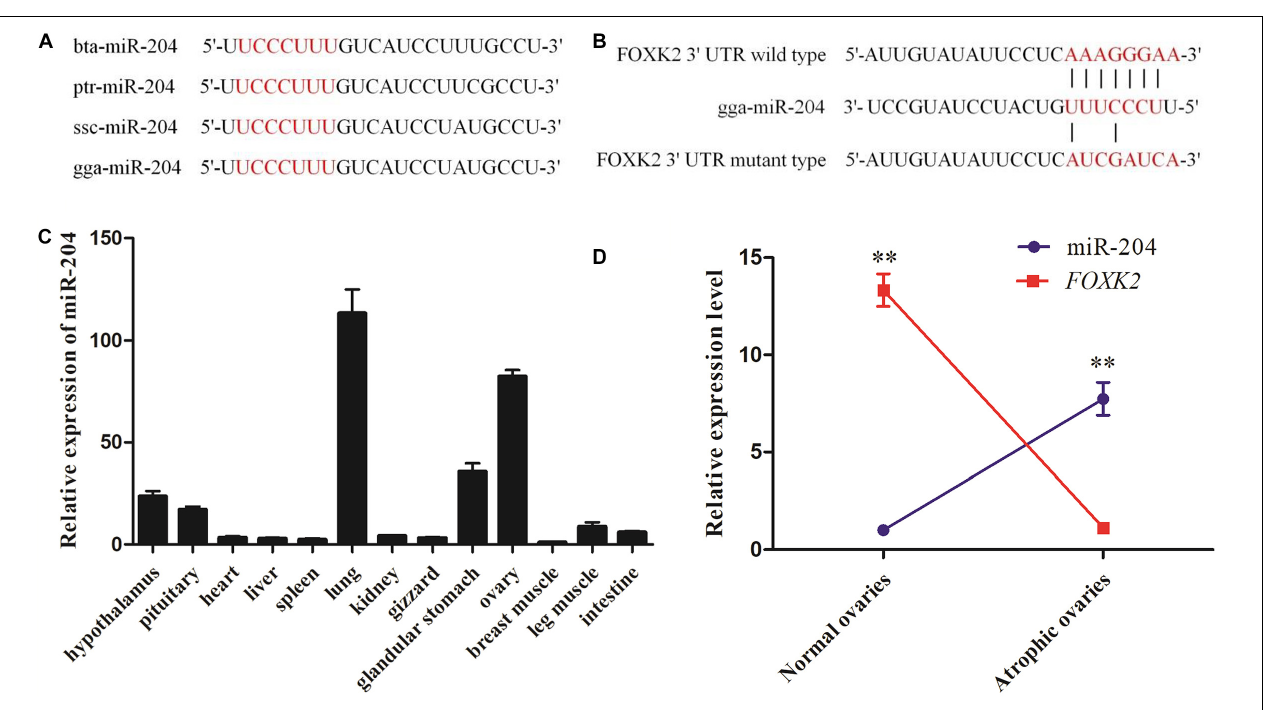
FIGURE 1 | Sequencing characteristics, expression patterns, and target gene prediction of miR-204 in chicken. (A) The mature sequence (red characters) of miR-204 among different animal species: gga, chicken; bta, cattle; ptr, chimpanzee; ssc, pig. (B) The target position of the miR-204 seed sequence on the gene Forkhead box K2 (FOXK2)-3 (cid:48) -untranslated region (UTR) sequence (red characters) was predicted by TargetScan software. (C) The expression patterns of miR-204 in chicken tissues including hypothalamus, pituitary, heart, liver, spleen, lung, kidney, gizzard, glandular stomach, ovary, breast muscle, leg muscle, and